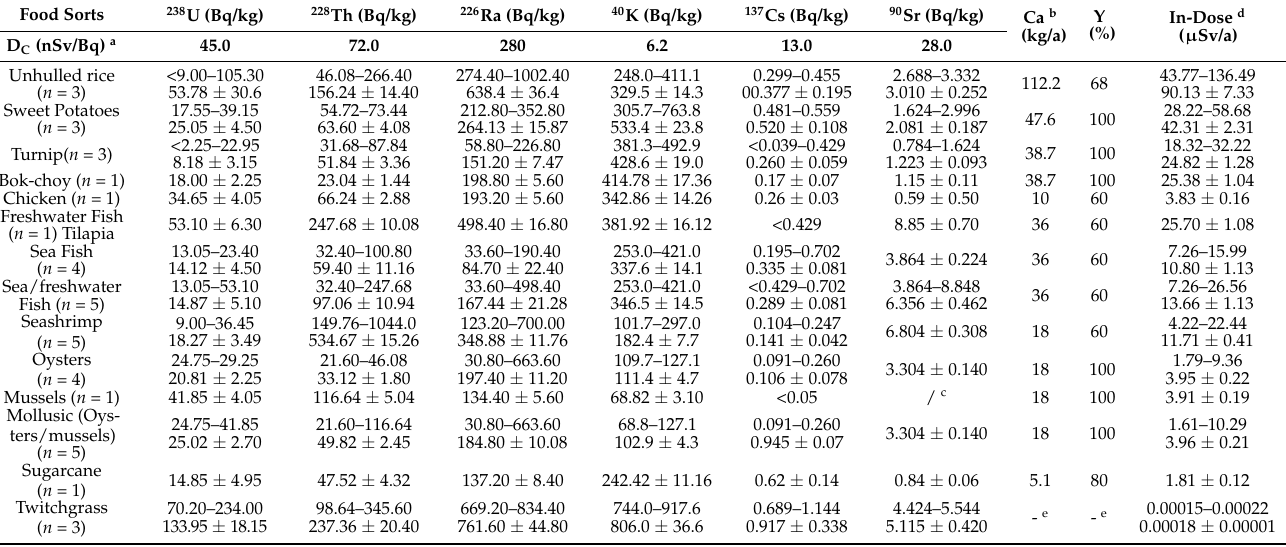
Table 2. Committed effective doses from ingesting food to